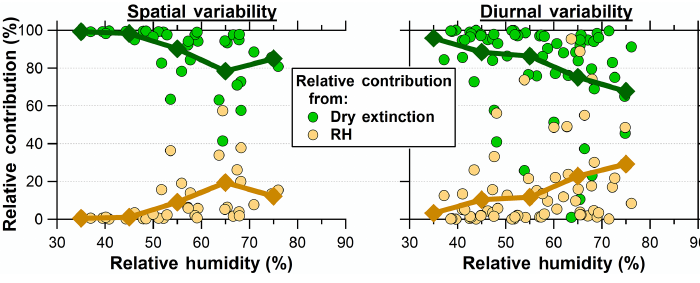
Figure 11. Relative contribution of dry extinction and RH to the spatial variability in ambient extinction as a function of RH (left) and to the diurnal variability (right). Diamonds represent the average relative contributions for 10%RH increments.